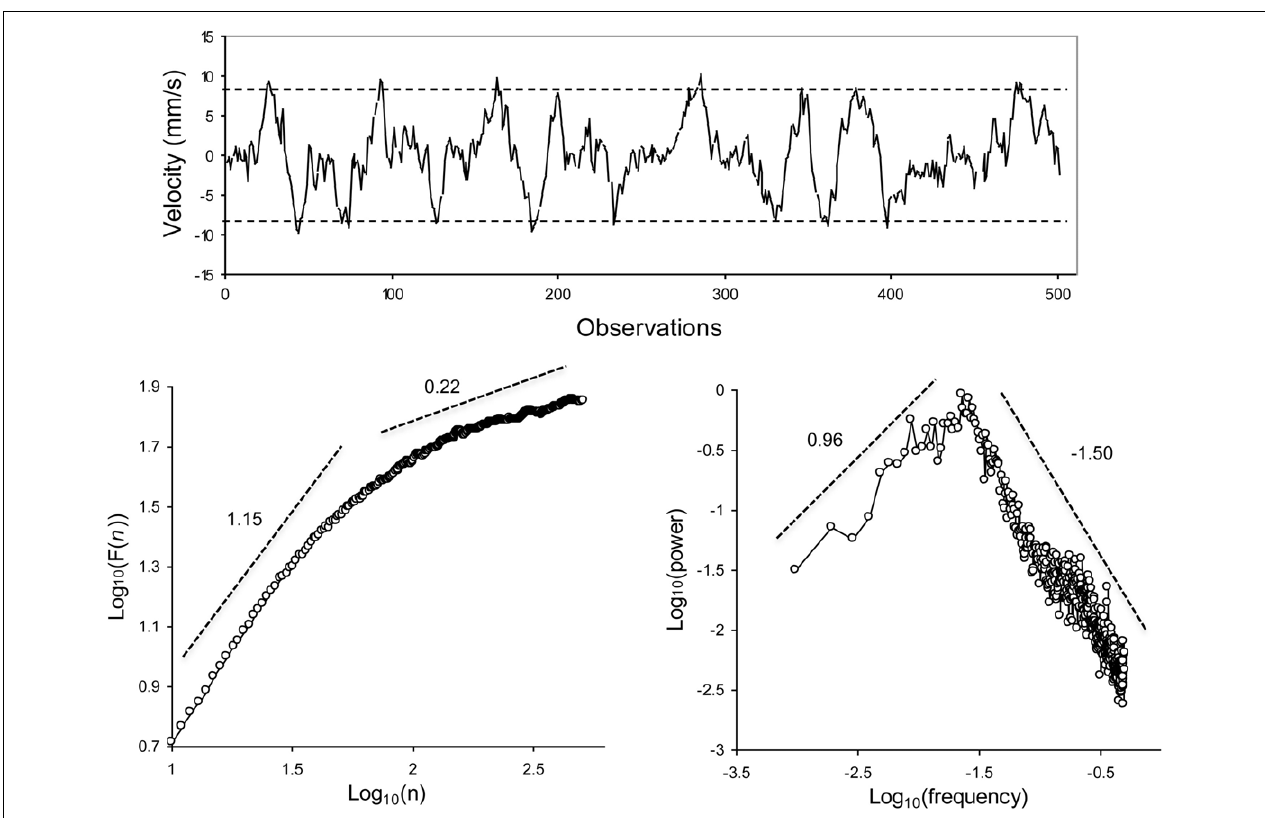
bound the evolution of the series. Bottom: average DFA diffusion plot (left) and average log–log power spectrum (right). From Delignières et al.